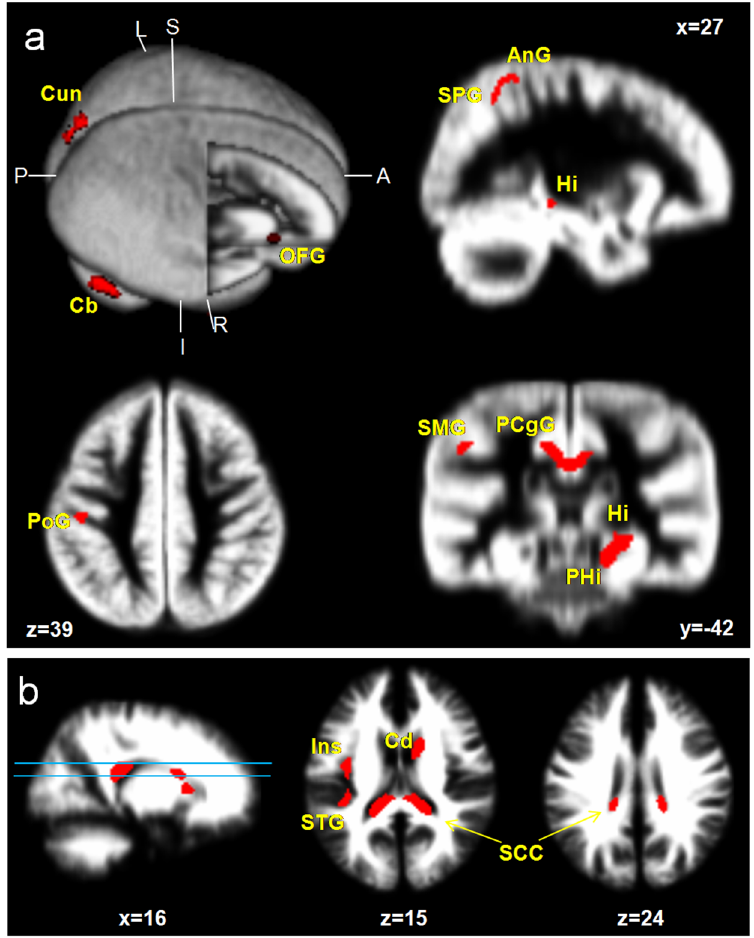
Figure 1. Brain areas with a significant increase in GM ( a ) and WM ( b ) volumes in ICPP girls in contrast to age-matched healthy girls (uncorrected; p < 0.001, excluded 100 voxels). Hi, hippocampus; PHG, parahippocampal gyrus; PCgG, posterior cingulate gyrus; Cun, cuneus; PoG, postcentral gyrus; SCC, splenium of corpus callosum; mPFC, medial prefrontal cortex; Ang, angular gyrus; SMG, supramarginal gyrus; SPG, superior parietal gyrus; STG, superior temporal gyrus; Ins, insula; Cd, caudate nucleus; Cb, cerebellar cortex. Table 2. Brain regions with a significant increase in GM and WM volumes in ICPP over age-matched controls (uncorrected; p < 0.001, excluded 100 voxels). Brain Area Abbr.